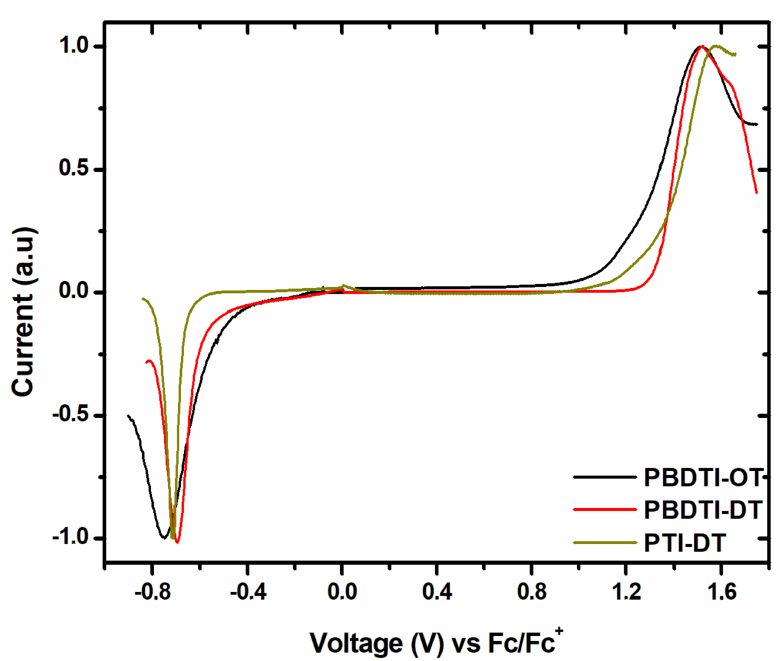
Figure 3. Square wave voltammograms of PBDTI-OD (black), PBDTI-DT (red) and PTI-DT (dark